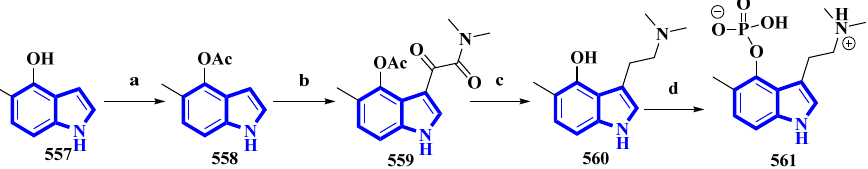
Figure 27. The semi-synthesis of 5-methylpsilocybin 561. (a) Ac 2 O, NaHCO 3 , toluene, 97%; (b) (1) oxalyl chloride and (2) (CH 3 ) 2 NH, THF, 77%; (c) LiAlH 4 , THF, 84%; (d) PsiK, ATP, MgCl 2 , H 2 O, 16 h, 44%. Table 2. Bioactivities of all novel indole alkaloids discussed in the article. (a) Tested as a mixture; (b) KB/VJ300 cells grown with vincristine (0.1 µ M), which did not affect their growth; (c) methicillin- resistant strain; (d) IC 90 ; (e) IC 40 . Compound Cytotoxicity (GI 50 ) µ M [Cell Line]